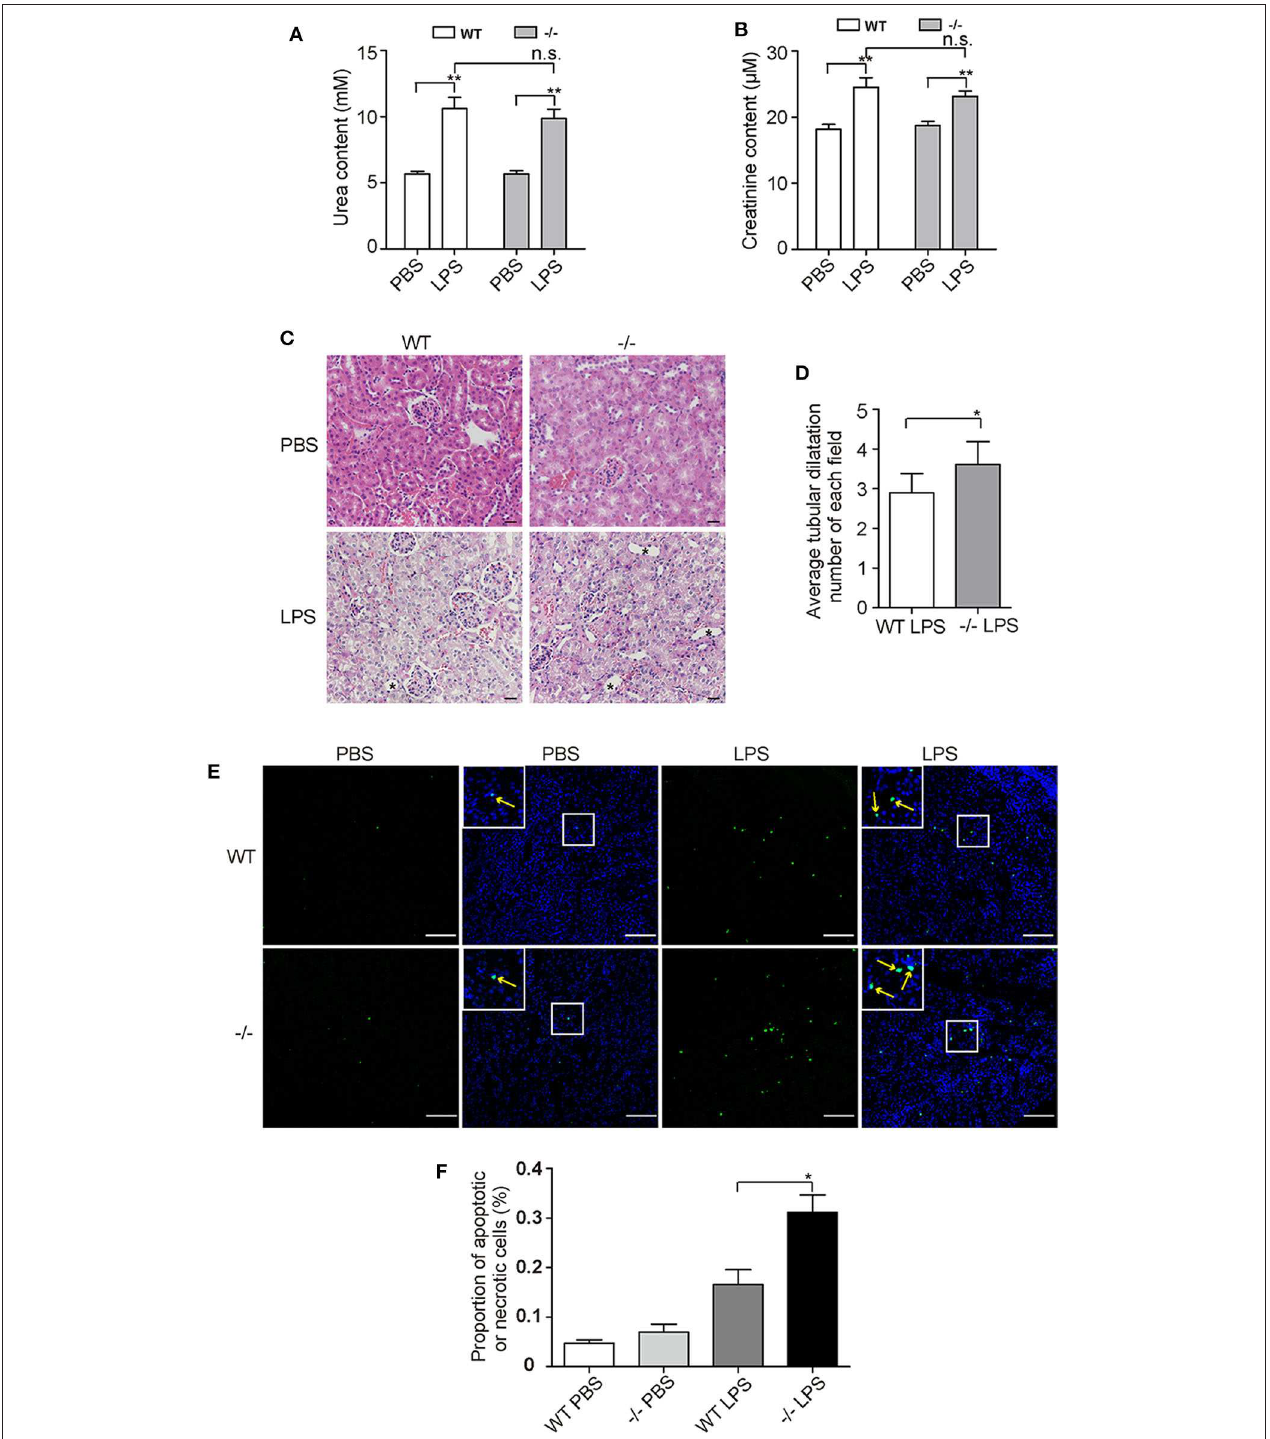
FIGURE 7 | Tests of kidney injury at 12h after LPS challenge. Three mice in each group were used. (A,B) Measurements of urea and creatinine content. (C) Hematoxylin and eosin (HE) staining of kidney sections. Pictures were taken at a magnification of 200 × . The slice thickness was 3 µ M. The bar is 20 µ M. Tubular dilations were marked by asterisks. (D) Average tubular dilation number of each field. Non-overlapped fields of one section were counted and averaged. (E) TUNEL staining of kidney sections. Pictures were taken at a magnification of 100 × . The green signals indicate nuclei of apoptotic or necrotic cell whose DNA strand breaks in nuclei were labeled by fluorescein-dUTP. The blue signals indicate total nuclei, which were stained with DAPI. The field in the upper left corner is the zoom picture in the white square box. Arrows point to the fluorescence positive points. The bar is 100 µ M. (F) Proportion of apoptotic and necrotic cells. Green fluorescence positive points that were overlapped with blue points of 10 non-overlapped fields were counted. Total nuclei numbers were recognized as total cell numbers counted by Image J. The ratio of fluorescence nuclei among total nuclei was calculated. * p < 0.05, ** p < 0.01, n.s., not significant.